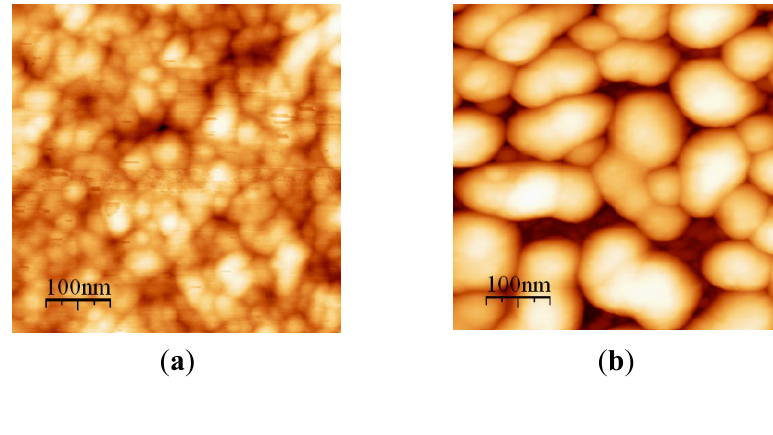
Figure 6. AFM image of Au-PTFE film 3 ( a ) T = 150 °C, size = 20–40 nm; ( b ) T = 220 °C, size = 80–110